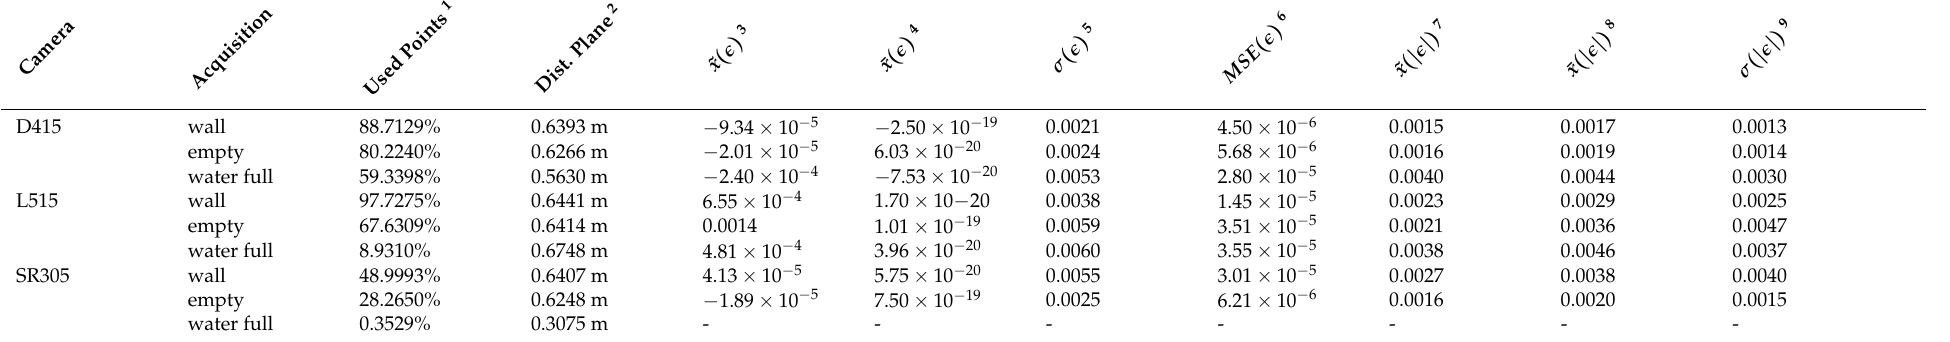
Table 4. Results for orthogonal distances to planes for the experiments wall , empty and water full .